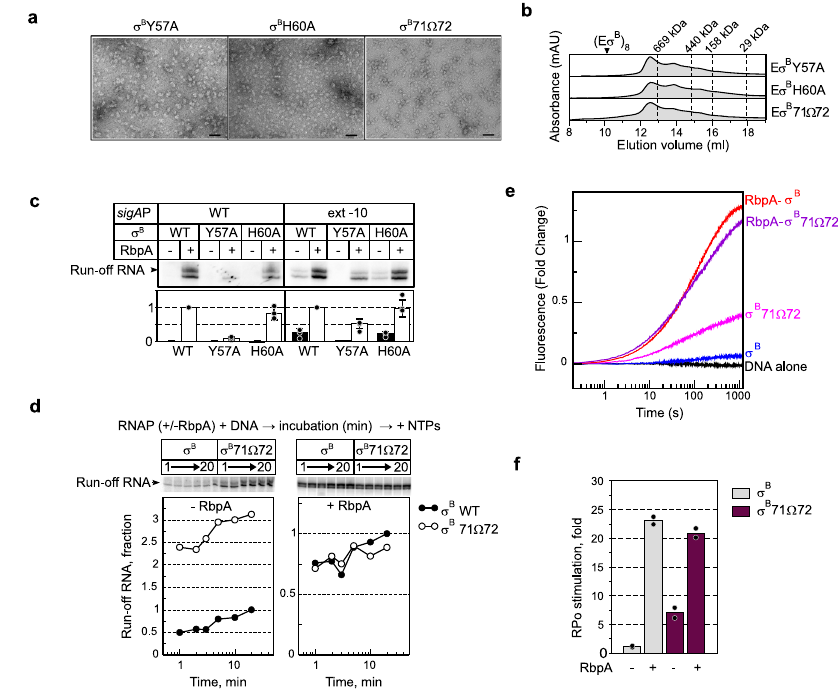
Fig. 6 | Role of σ B NCR in octamer assembly and RPo formation. a Negatively Data are presented as mean values ±SD of three independent experiments. d Kinetics of promoter binding by the E σ B 71 Ω 72 mutant in run-off transcription stained images of E σ B harboring the following mutant σ subunits: σ B -Y57A, σ B - H60A, and σ B 71 Ω 72. Scale bar=50nm. Experiments were repeated independently assays using the sigA Pext-10 promotervariant.The experimentalschemeis shown at the top. Inserts show run-off RNA products. Graphs show the normalized twicewithsimilarresults. b AssessmentofthemutantRNAPsoligomerizationstate amounts of run-off RNA ( σ B 71 Ω 72 vs σ B ) as a function of time. e Fluorescence fold- bySEC.Elutionpro fi lesoftheRNAPcore(E)incomplexwith σ B -Y57A, σ B -H60A,and σ B -71 Ω 72. Expected position of the octamer peak is indicated as (E σ B ) change during RPo formation kinetics by E σ B and E σ B 71 Ω 72 on the Cy3-labeled 8 . c Transcriptional activity of Mtb RNAP harboring σ B (WT) and σ B mutants (Y57A, sigA Pext-10 promoter without or with RbpA. f RPo fractions at equilibrium in the H60A). Transcription was initiated at the wild-type sigA P (WT) and sigA Pext-10 time-resolved fl uorescence assay shown in d . Values were normalized to the value promoterseitherwithout(-)orwith(+)RbpA.Gelsshow[ α 32 P]-labeledrun-offRNA for E σ B . Data points from two technical replicates are shown. Mean values are products.Bargraphshowsthebandquanti fi cation.Foreachpanel,therun-offRNA presented as bar graphs. Source data are provided as a Source Data fi amountswerenormalizedtotheRNAamountsynthesizedinthepresenceofRbpA.